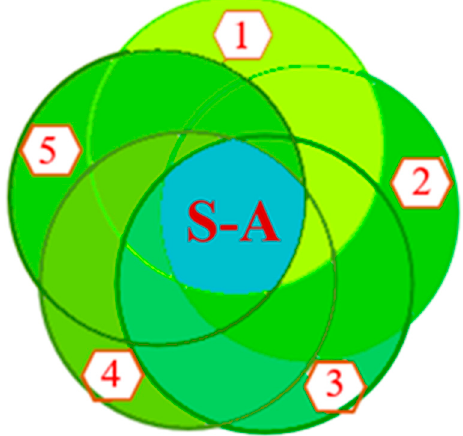
Figure 31. The analysis process of the BCPPMAs’ performances.